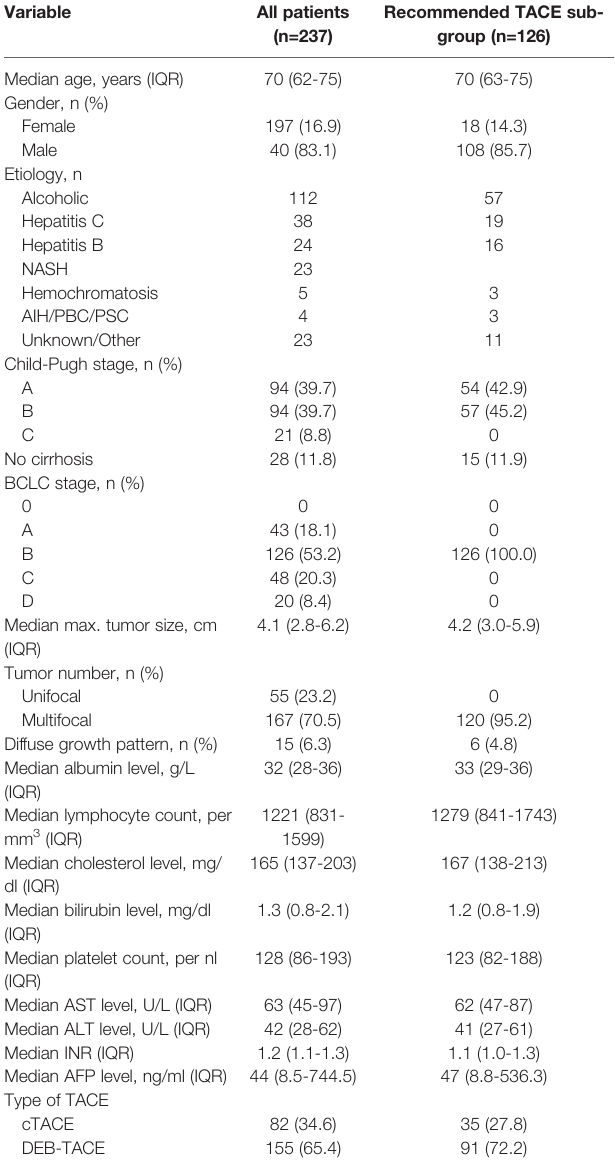
TABLE 1 | Baseline characteristics of patients with HCC undergoing TACE. Variable All patients